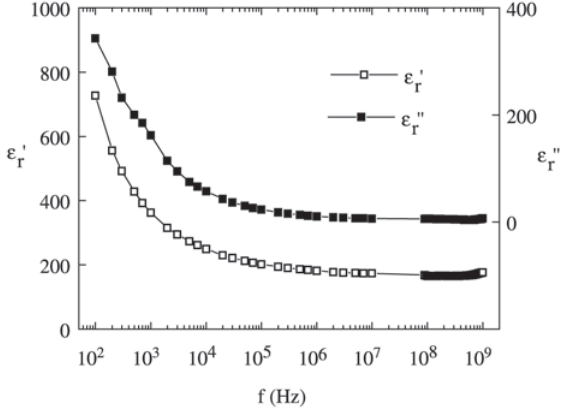
Figure 5. Dielectric response for the PLTM ferroelectric ceramic including the low and high frequency range (100 Hz to 2 GHz), at room